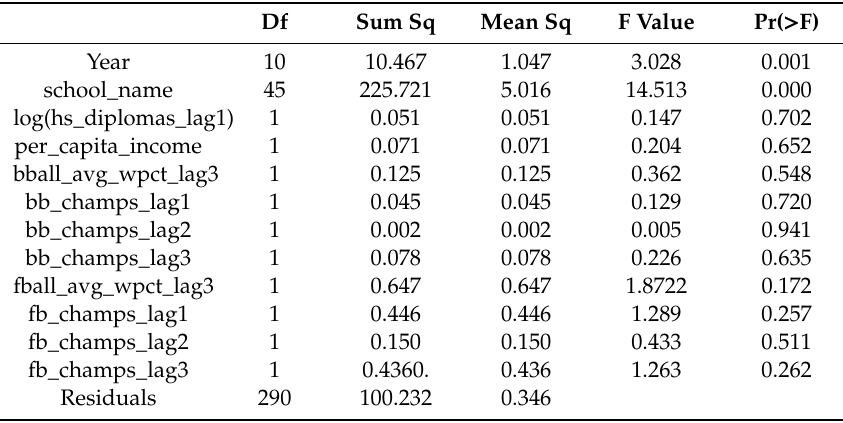
Table A4. ANOVA table for